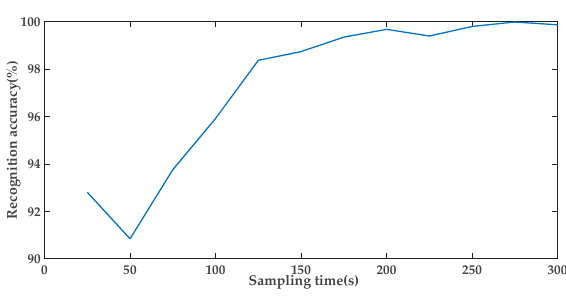
Figure 9. The principle of on-line recognition.